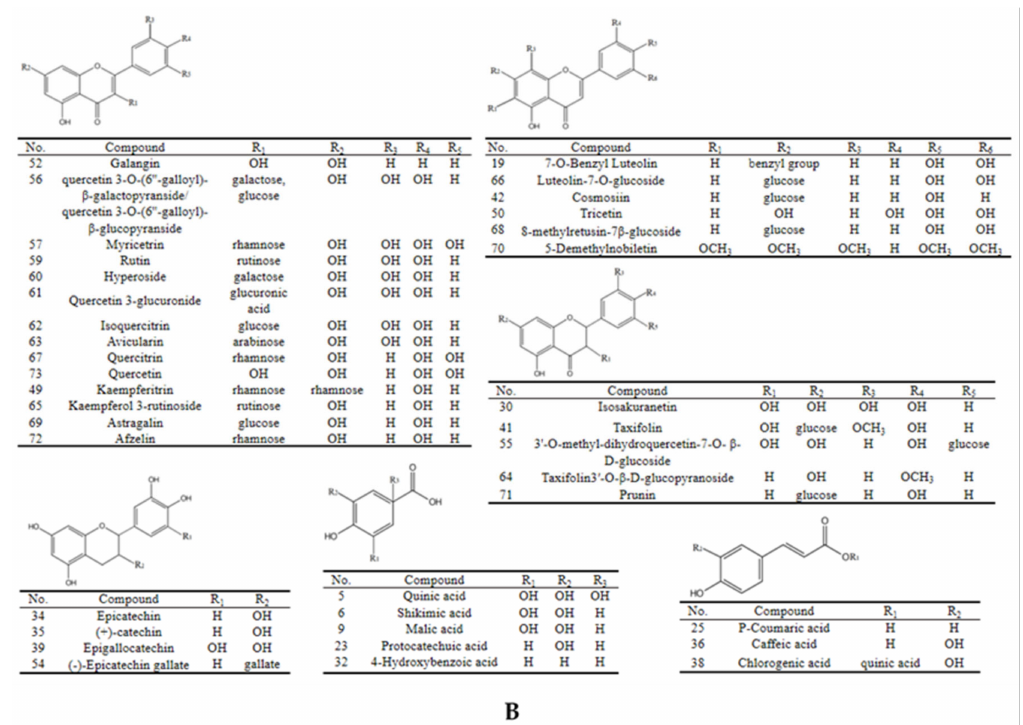
Figure 2. Chemical structures of compounds identified in the Taxilli Herba ( A ) exact structures, ( B ) general structures.